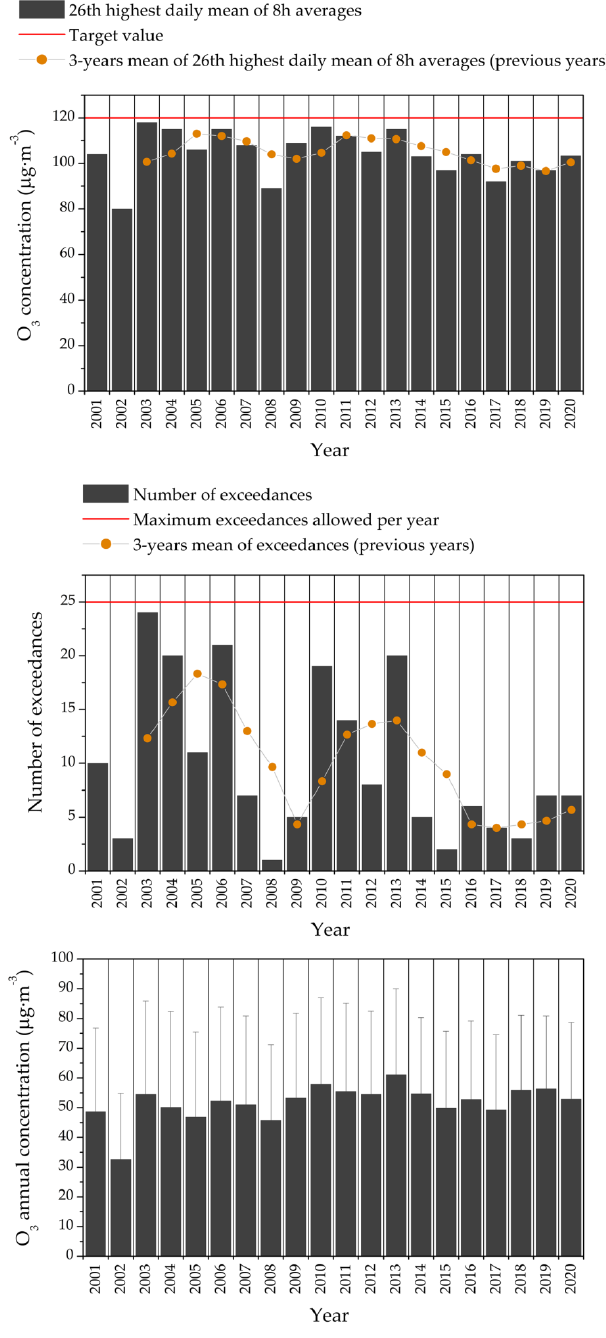
3 Figure 3. Levels of O 3 in Seixal from 2001 to 2020: ( top ) 26th highest hourly means, ( center ) number of exceedances, ( bottom ) annual